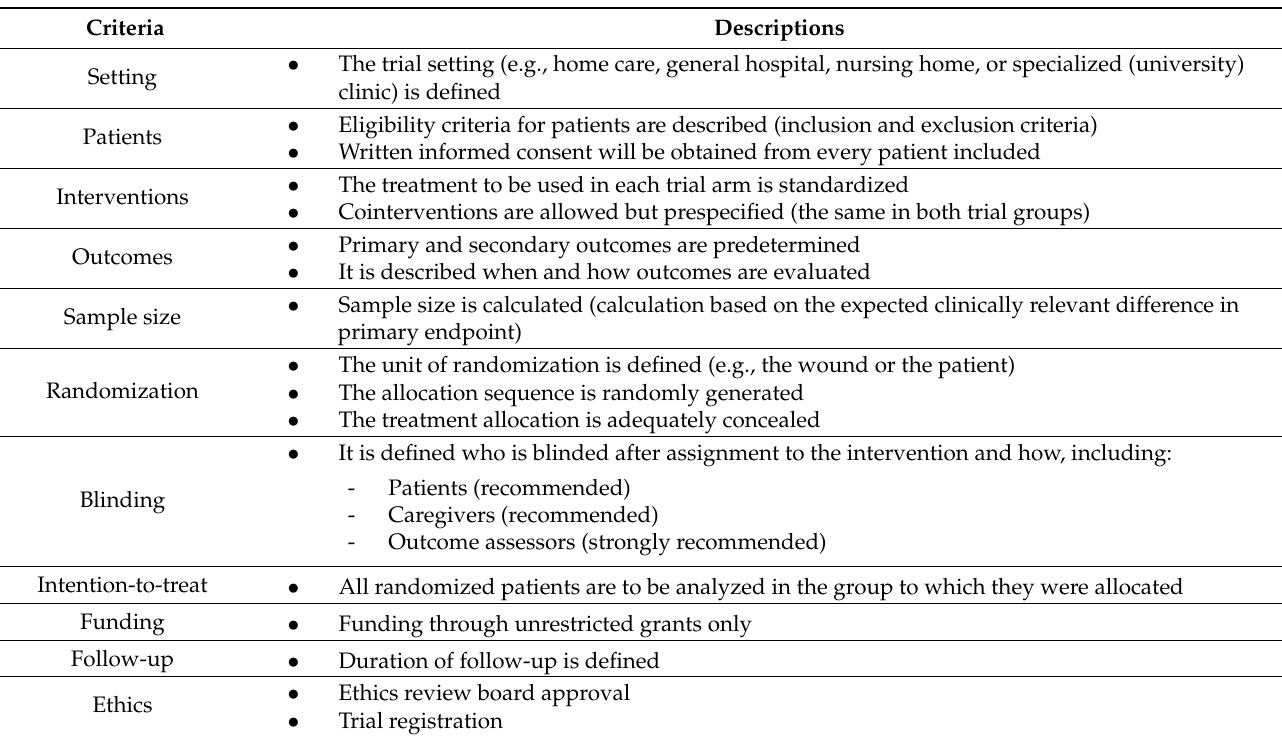
Table 5. Checklist of criteria to be defined and completed for an optimum design in wound care clinical trials